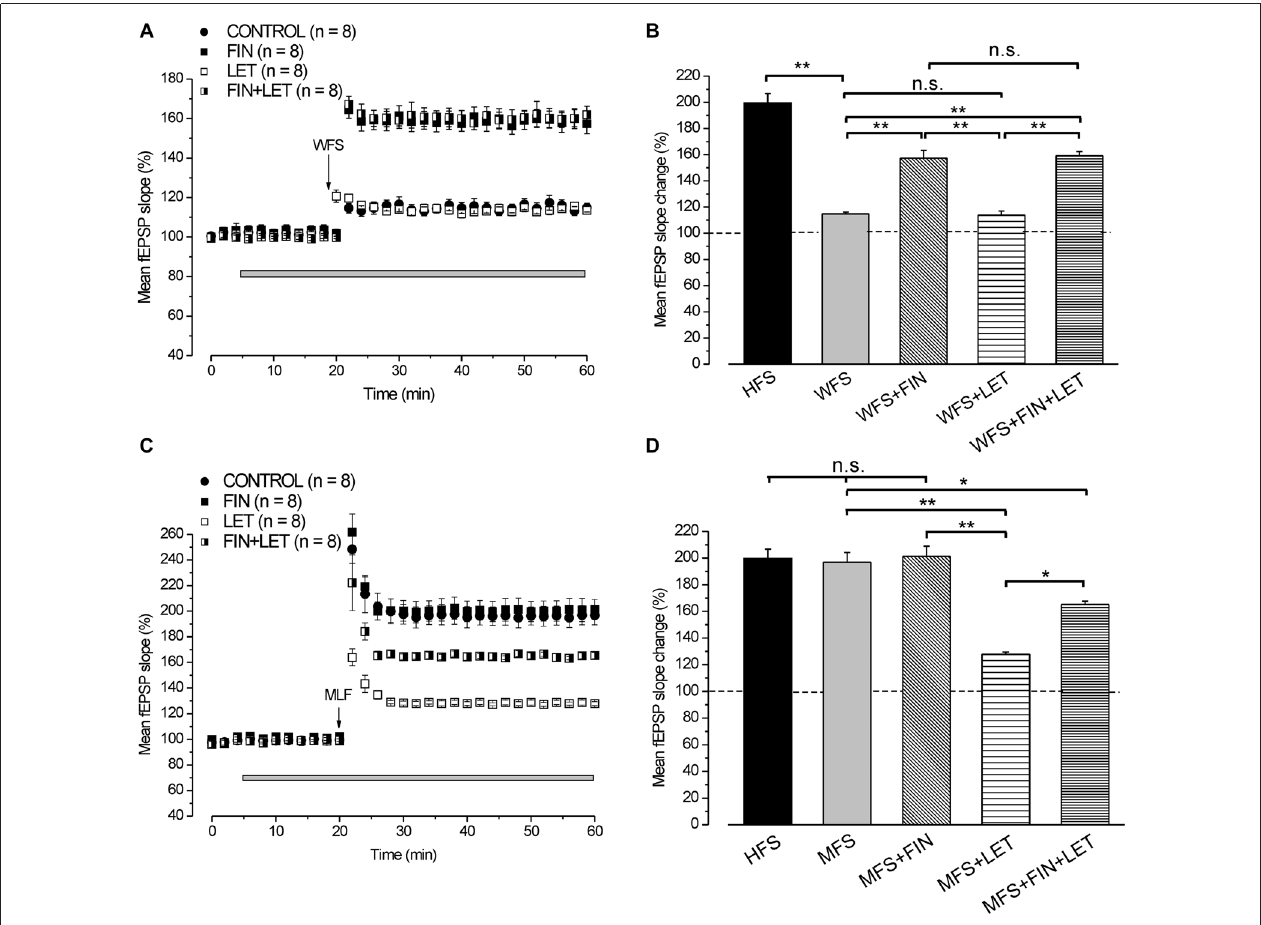
FIGURE 5 | LTP induced by WFS (1 s-25 Hz) and MFS (1 s-50 Hz). (A) Effect of WFS in control condition (filled circles), in the presence of FIN (filled squares), LET (open squares) and FIN + LET (half-filled squares). (B) Comparison among LTP induced by HFS in control condition and by WFS in the different conditions as shown in A (one-way ANOVA, F 4,44 = 42.25, p < 0.0001; Tukey’s post hoc test ∗∗ p < 0.001). (C) Effect of MFS in control condition (filled circles), in the presence of FIN (filled squares), LET (open squares) and FIN + LET (half-filled squares). (D) Comparison among LTP induced by HFS in control condition and by MFS in the different conditions as shown in C (one-way ANOVA, F 4,43 = 16.76, p < 0.0001; Tukey’s post hoc ∗∗ p < 0.001, ∗ p < 0.05). Note that the synthesis of DHT is mainly implied in the WFS induced LTP, while that of E2 is only involved in LTP induced by MFS.